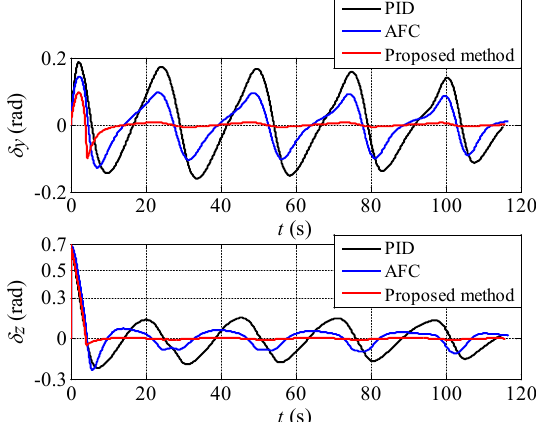
Figure 15. The aiming error angles of the UCAV during the process of attack guidance.